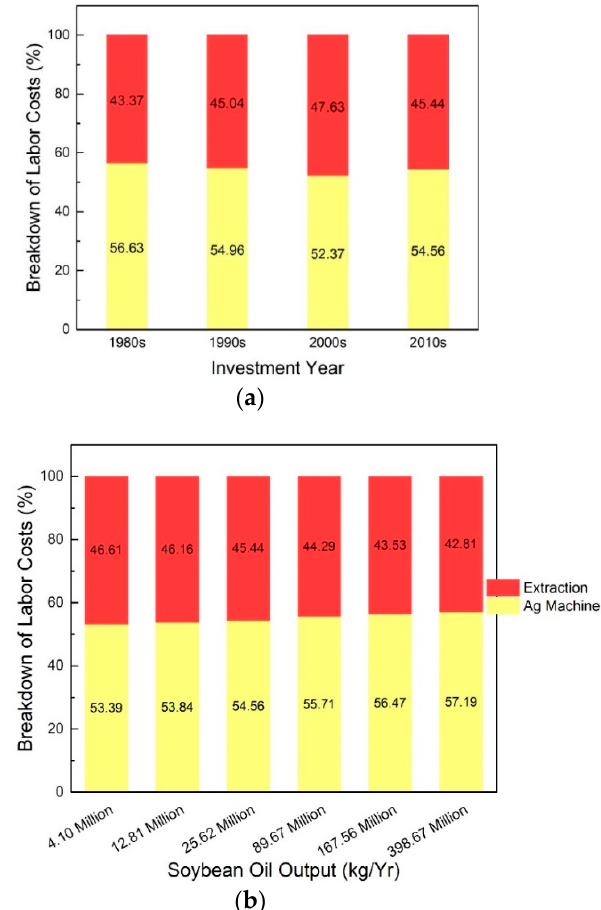
Figure 5. Labor costs. ( a ) 1980-2015 data; ( b ) Various scales of oil production.